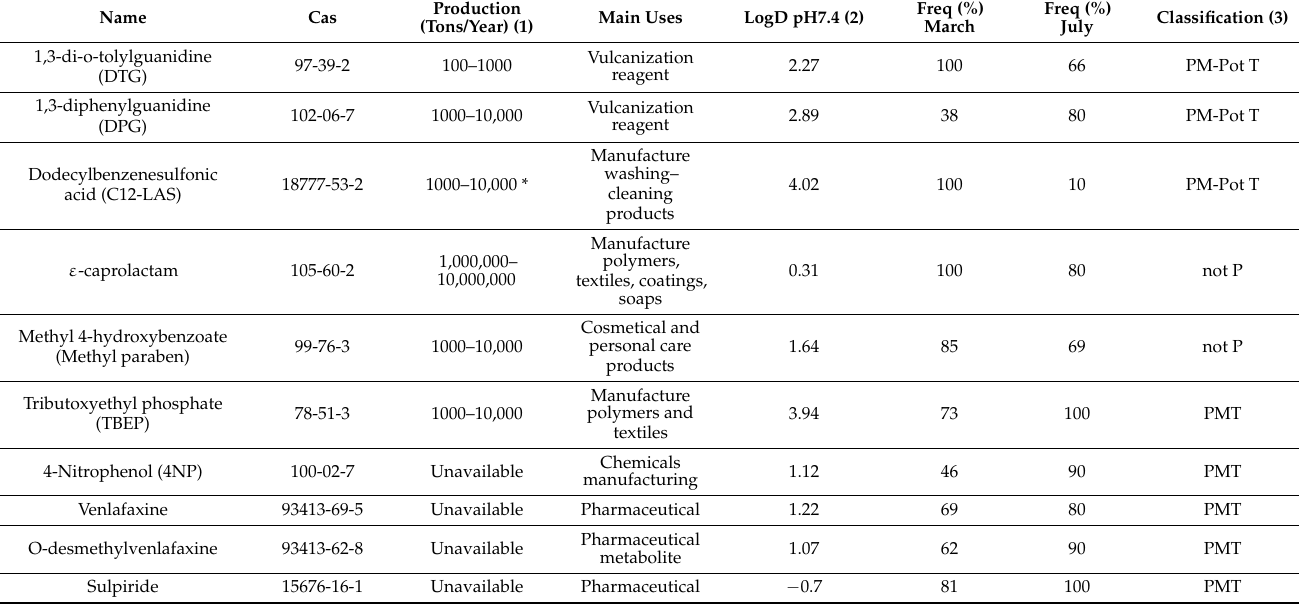
Table 1. Topmost frequently detected